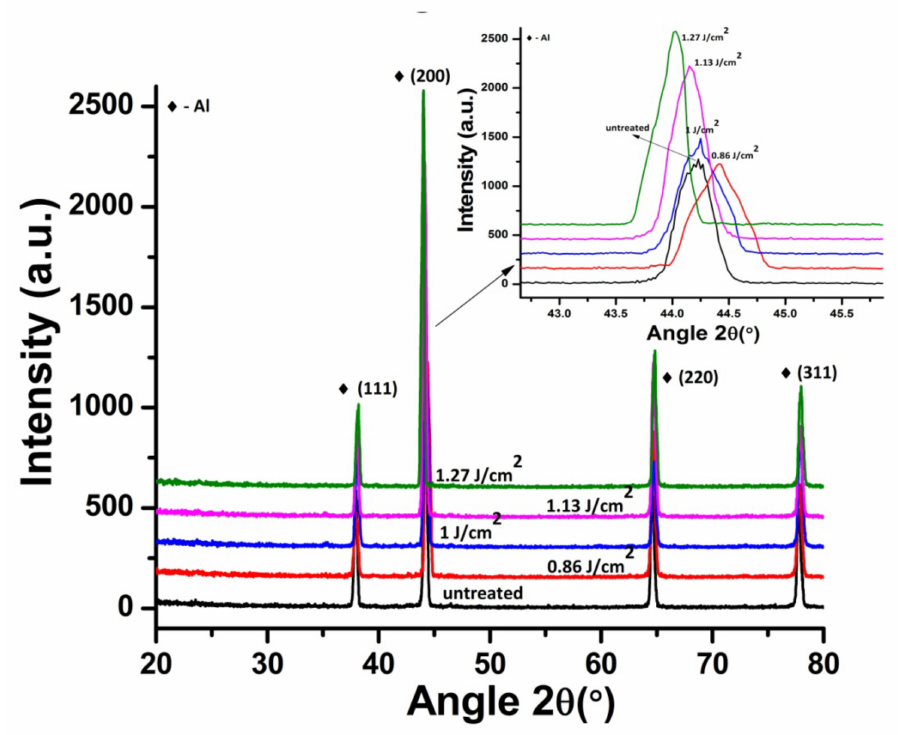
Figure 7. XRD data of un-irradiated and irradiated Al exposed to 100 pulses of ns laser in Ar environment at pressure of 100 torr, at various fluences of 0.86, 1, 1.13 and 1.27 J · cm − 2 . Inset of Figure 7 reveals the enlarged view of Al (200) peak, showing variation in peak position and peak